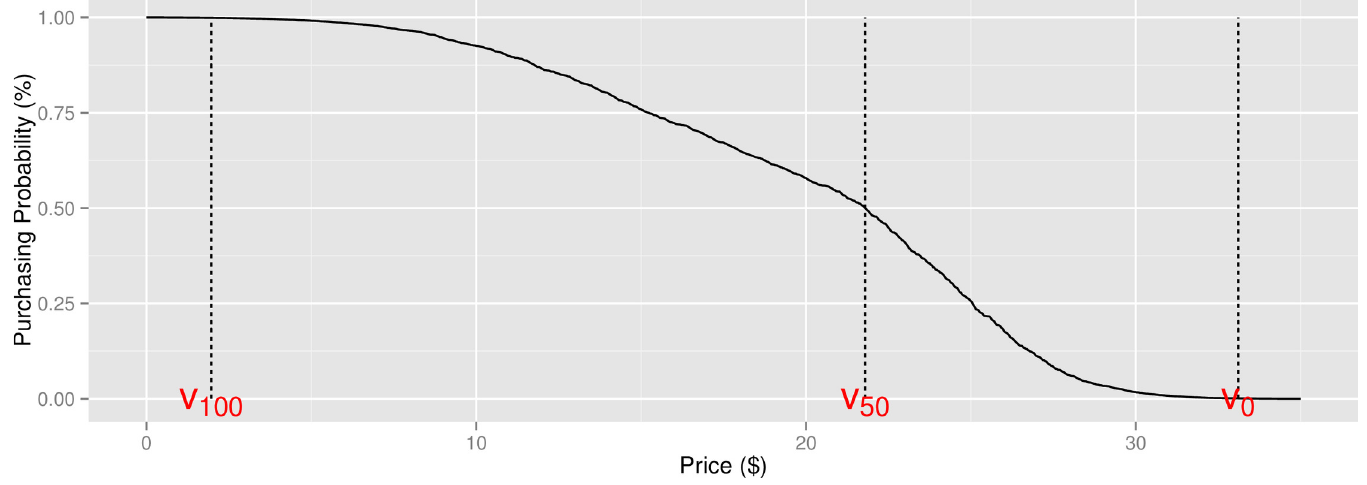
Fig 3. Three interpretations of reservation price: Floor RP, indifferent RP, and ceiling